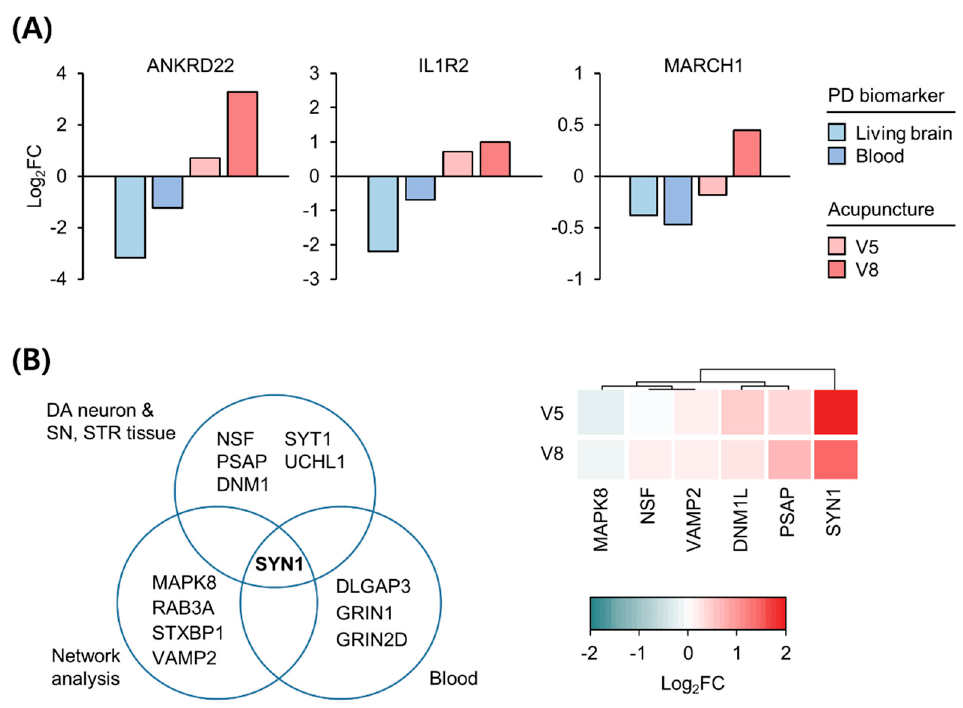
Figure 3. Expression changes in PD biomarkers following acupuncture treatment. ( A ) Three PD biomarkers consistently decreased in living brain and blood transcriptome versus healthy controls. Previously reported values of biomarker gene expression changes were compared with the changes in the representative patient’s blood at V5 and V8 compared to V1. ( B ) Suggested PD biomarkers based on postmortem brain tissue, blood, and network analysis (left). Expression changes in genes in the representative patient’s blood at V5 and V8 compared to V1 (right). Red and blue colors denote increased and decreased expressions, respectively. FC, fold change; PD, Parkinson’s disease.